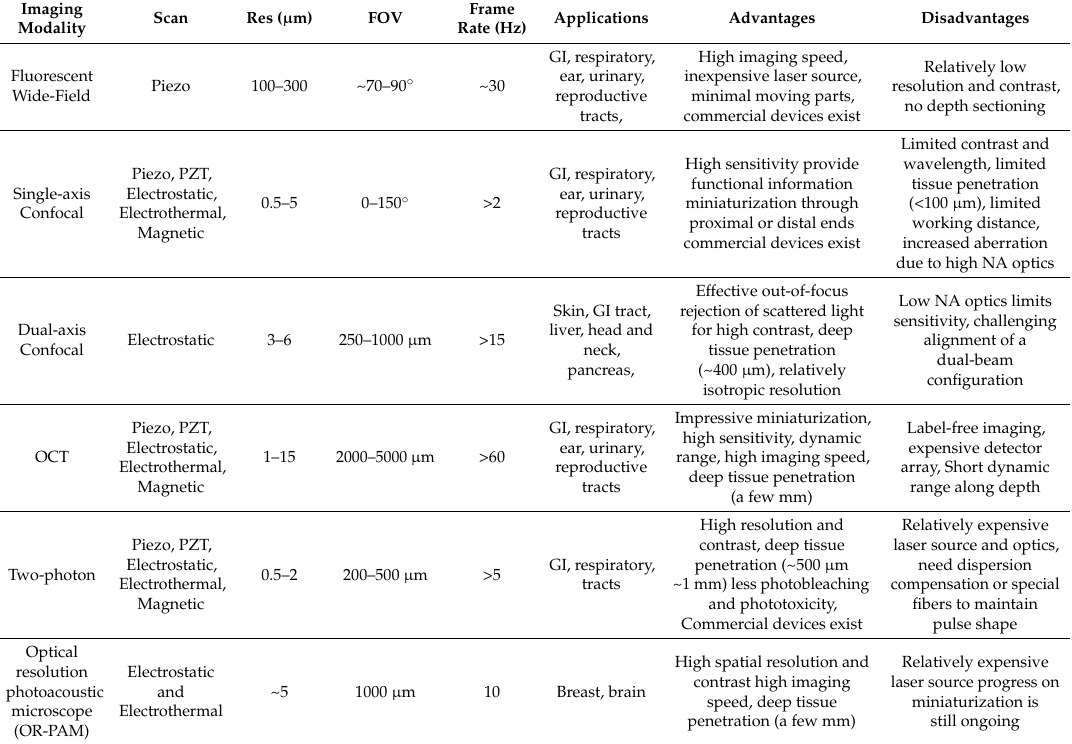
Table 1. MEMS scanning mechanisms developed for in vivo optical